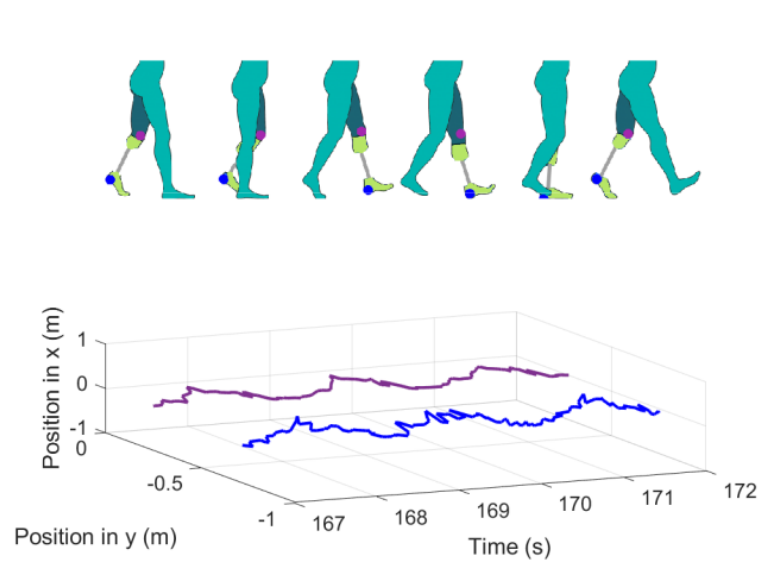
Figure 16. Left amputee gait cycle paired with lateral position of left knee and prosthetic foot from the second 167 to